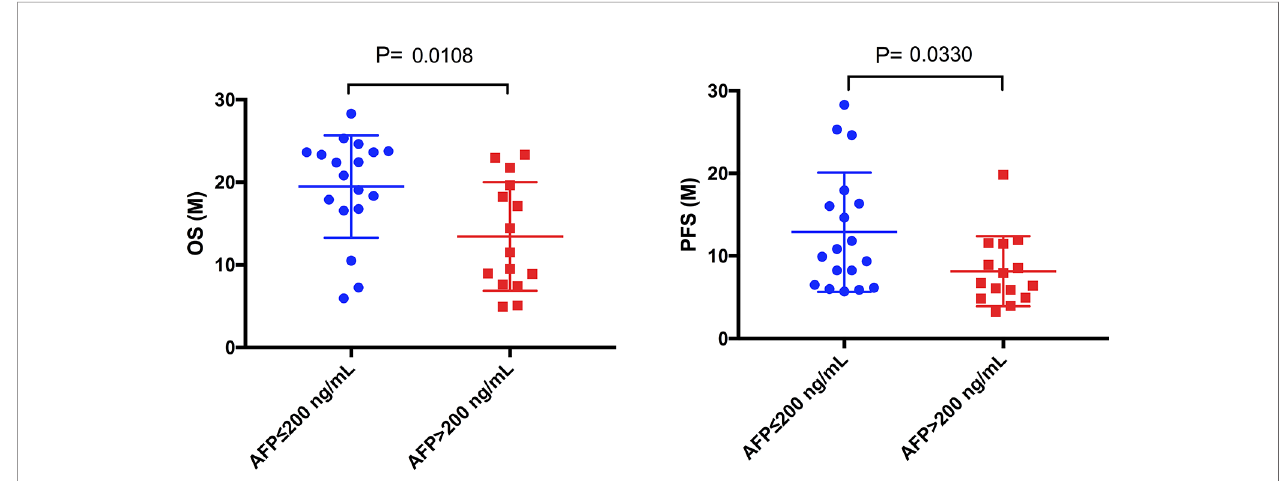
FIGURE 6 | Comparison of mOS and mPFS between the low AFP and high AFP groups in HCC patients. The mOS of the low AFP group was signi fi cantly longer than that of the high AFP group (19.48 months vs. 13.43 months, P = 0.0108), as was the mPFS (12.88 months vs. 8.16 months, P =